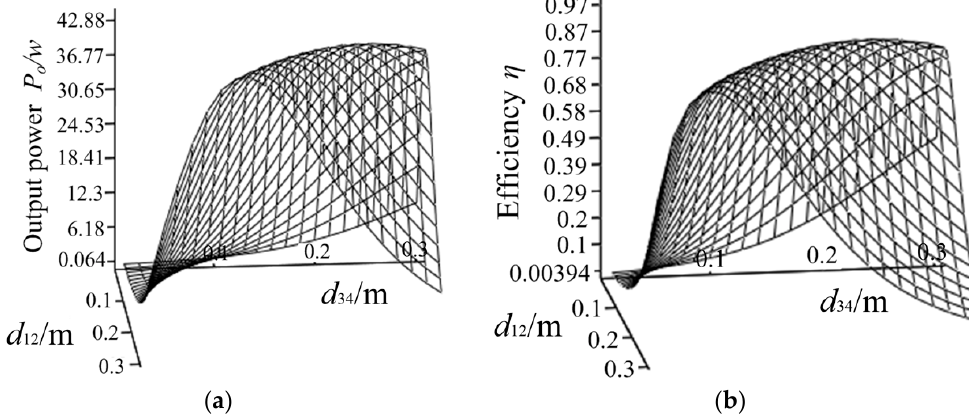
Figure 8. Output power P 0 ( a ) and e ffi ciency η ( b ) with respect to d 12 and d 34. Table 3. Main design parameters of the coils.